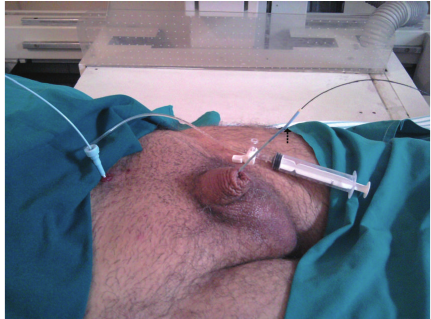
Figure 3: The angiographic catheter (dotted arrow) has been advanced across the stenosis over the guidewire.